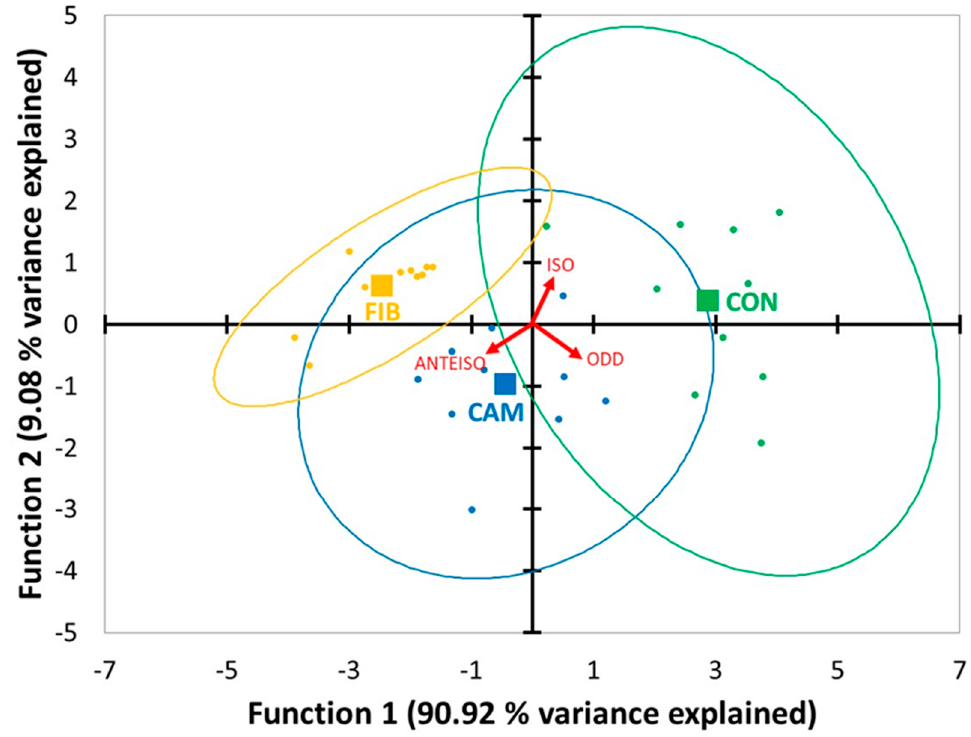
Figure 1. Canonical discriminant plot. Observations correspond to three type of diets: a typical commercial concentrate rich in starch and based on cereals and soybean meal (CON, green dots); a typical commercial concentrate which replaces 50% of soybean meal with camelina meal (CAM, blue dots); and a concentrate rich in neutral detergent fiber based on fibrous by-products and not including cereals or soybean meal (FIB, yellow dots). Centroids are indicated by squares of the corresponding color. Variable correlations with the discriminant functions are represented by red